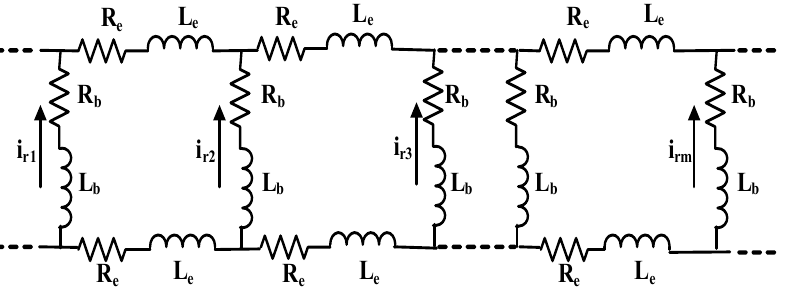
Figure 4. Squirrel-cage rotor equivalent circuit.